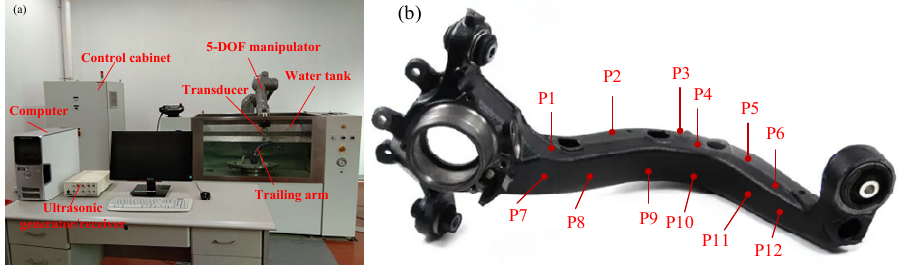
Figure 3. Automatic ultrasonic measurement: ( a ) experimental setup; ( b ) a trailing arm.